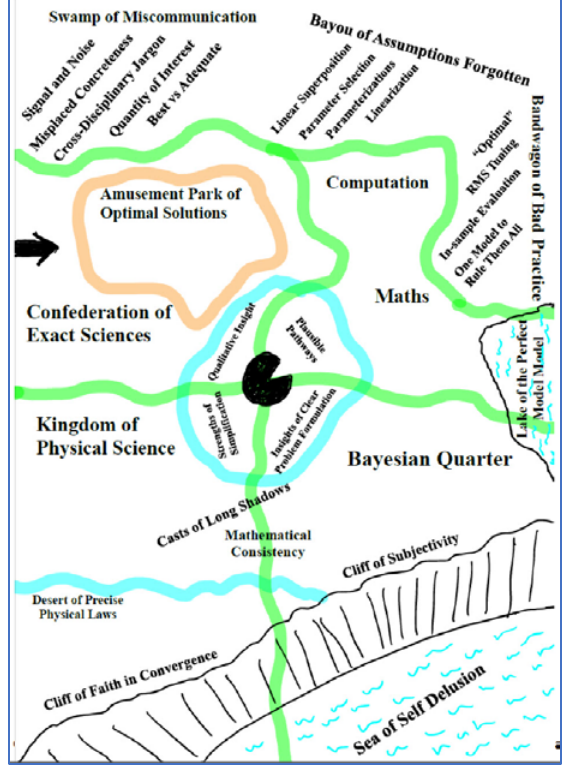
Figure 1 : A map of Model-land. The black hole in the middle is a way